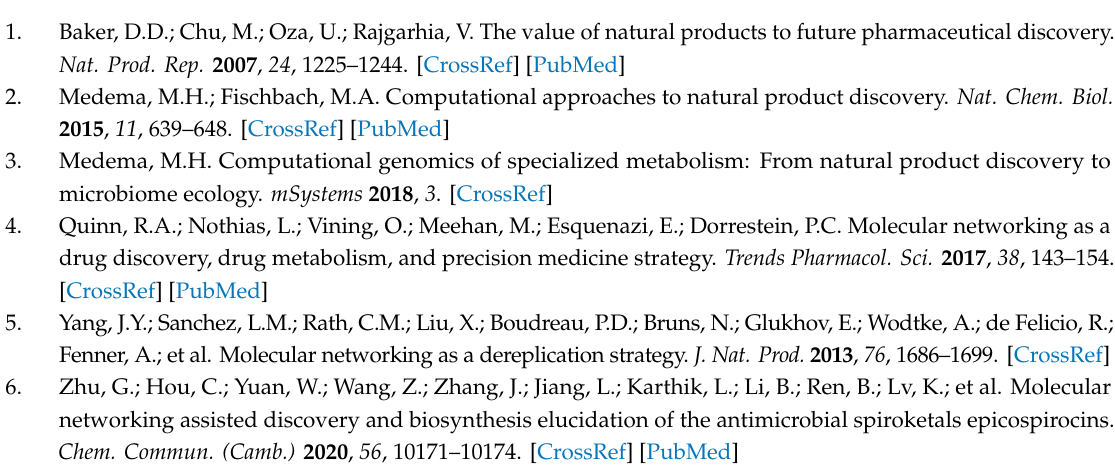
MS / MS data from extract of strain PJS, Figure S2: UPLC-UV-MS chromatogram of crude extract from strain PJS, Figure S3a: The MS / MS spectrum and possible fragmentation patterns of compounds 1 – 5 , Figure S3b: The MS / MS spectrum and possible fragmentation patterns of compounds 6 – 10 , Figure S4: The HR-ESI-MS spectrum of compound 1 , Figure S5: The 1 H NMR spectrum of compound 1 in DMSO- d 6 (500 MHz), Figure S6: The 13 C NMR spectrum of compound 1 in DMSO- d 6 (125 MHz), Figure S7: The HSQC spectrum of compound 1 in DMSO- d 6 , Figure S8: The COSY spectrum of compound 1 in DMSO- d 6 , Figure S9: The HMBC spectrum of compound 1 in DMSO- d 6 , Figure S10: The 1 H NMR spectrum of compound 1 in CD 3 OD (500 MHz), Figure S11: The 13 C NMR spectrum of compound 1 in CD 3 OD (125 MHz), Figure S12: The CD spectrum of compound 1 , Figure S13: The HR-ESI-MS spectrum of compound 2 , Figure S14: The 1 H NMR spectrum of compound 2 in DMSO (600 MHz), Figure S15: The 13 C NMR spectrum of compound 2 in DMSO- d 6 (150 MHz), Figure S16: The DEPT 90 spectrum of compound 2 in DMSO- d 6 (150 MHz), Figure S17: The DEPT spectrum 135 of compound 2 in DMSO- d 6 (150 MHz), Figure S18: The HSQC spectrum of compound 2 in DMSO- d 6 , Figure S19: The COSY spectrum of compound 2 in DMSO- d 6 , Figure S20: The HMBC spectrum of compound 2 in DMSO- d 6 , Figure S21: The NOESY spectrum of compound 2 in DMSO- d 6 , Figure S22: The CD spectrum of compound 2 , Table S1: The MS / MS fragment ions of two new antibiotics ( 1 – 2 ) and compounds 3 – 10 , Table S2: Minimum inhibitory concentrations (MICs) of hetiamacin E ( 1 ) and hetiamacin F ( 2